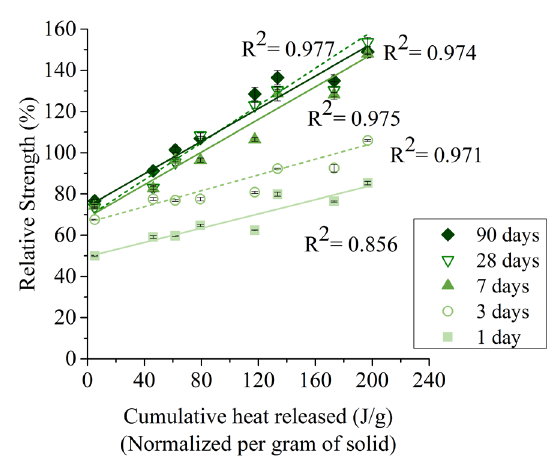
Figure 3. Plot of cumulative heat release at 1 day in Ca(OH) 2 – calcined clay model systems cured at 40 °C versus the relative strength of a calcined clay blended cement mortar (30% replacement) prepared and tested according to EN 196-1 at 1 to 90 days of hydration. Beyond 1 day of hydration there is a close correlation between the reactivity of the calcined clay and the contribution to compressive strength. Modified after